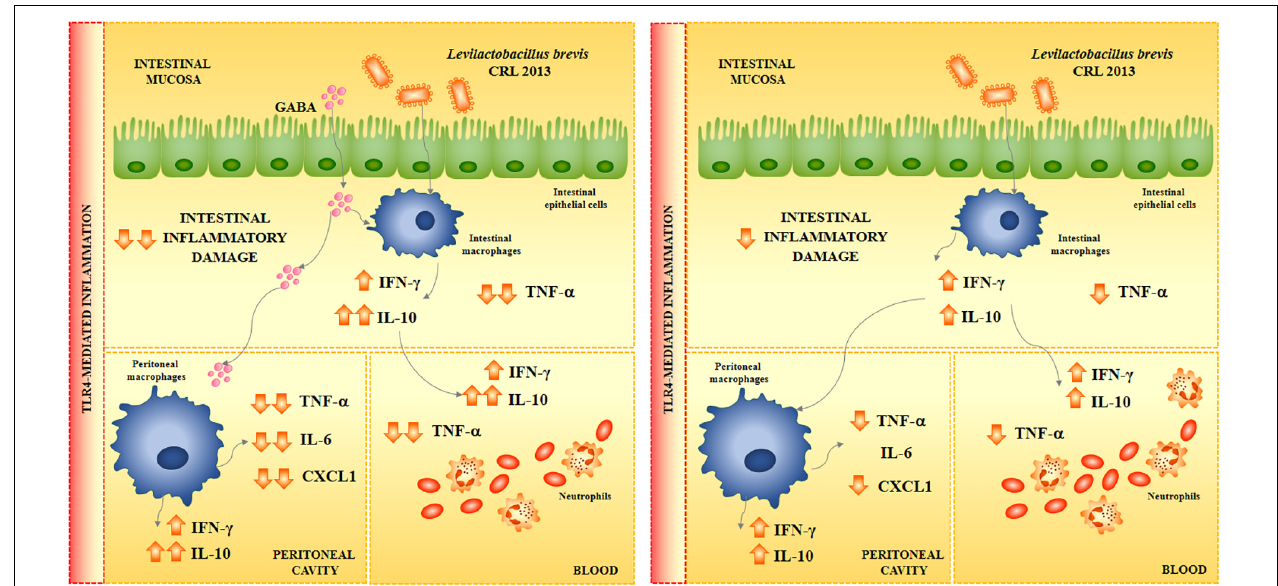
FIGURE 8 | Proposed mechanism for the immunomodulatory effect of Levilactobacillus brevis CRL 2013 and GABA in the immune response triggered by the activation of